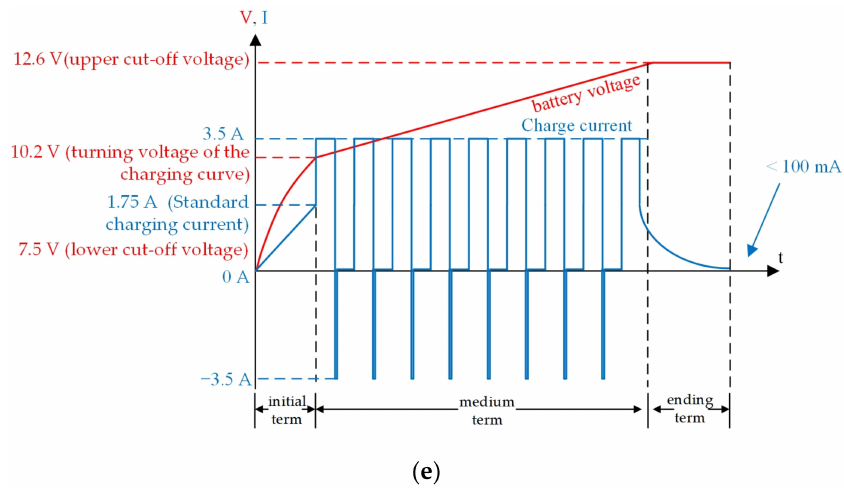
Figure 6. Voltage and current waveform of different charging methods used in the mid-term: ( a ) CC, ( b ) PC, ( c ) TC, ( d ) SC, and ( e ) Reflex-current.